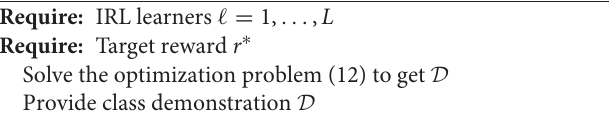
Algorithm 2 J OINT T EACH : Approximate teaching multiple IRL